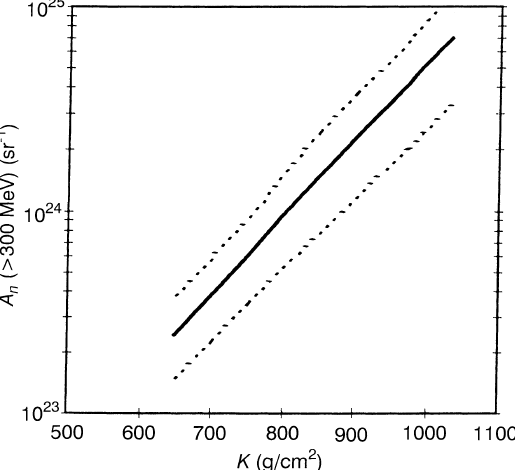
Fig. 8. The calculated number ( solid line ) of neutrons injected from the Sun towards the Earth per count of a 6NM64 monitor vs. the altitude of the NM station. The Sun is assumed to be in the zenith. Dotted lines correspond to estimated uncertainties of (cid:6)